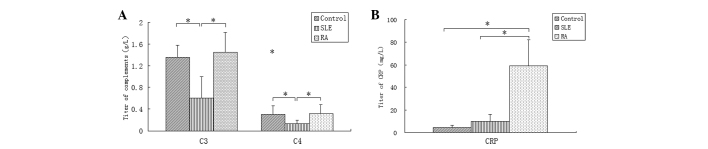
Titration and comparison of complements and CRP among control, SLE or RA patients. (A) The complement C3 and C4 titers of SLE patients (n=347) were significantly lower than those of RA patients (n=382) and controls (n=66; *P<0.05). (B) The CRP titer of RA patients (n=382) was significantly higher than those of SLE patients (n=347) and controls (n=66; *P<0.05). CRP, C-reactive protein; SLE, systemic lupus erythematosus; RA, rheumatoid arthritis.